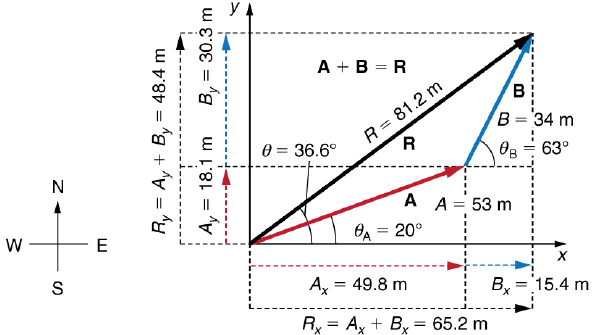
Fig. 1 Schematic diagram of the relationship between physical quantities in the exertion